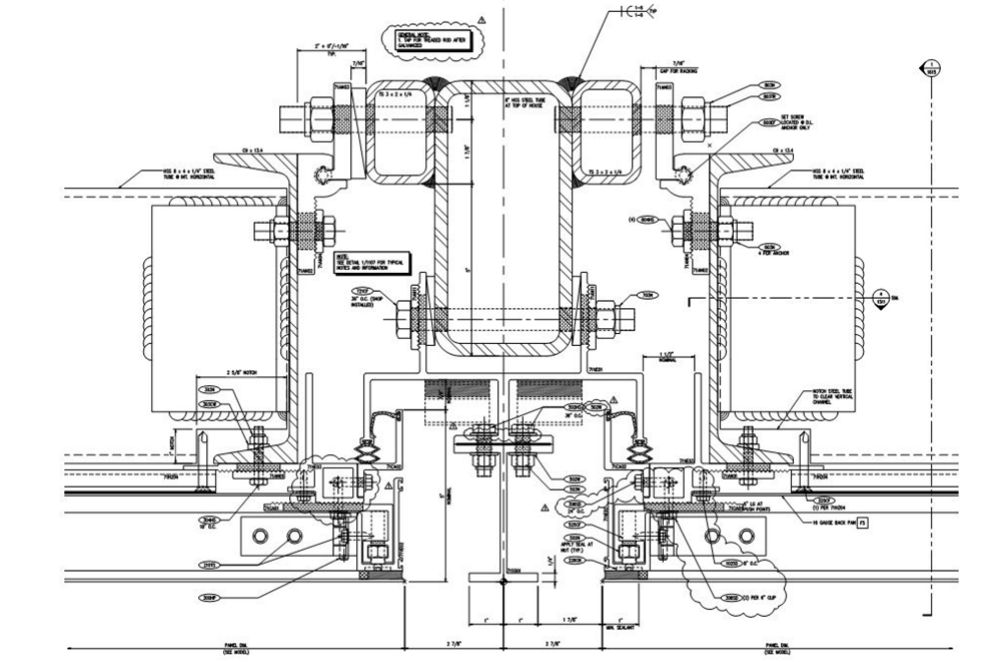
Fig. 4 Sloped Façade Detail of Unitized System and Rafter Assembly